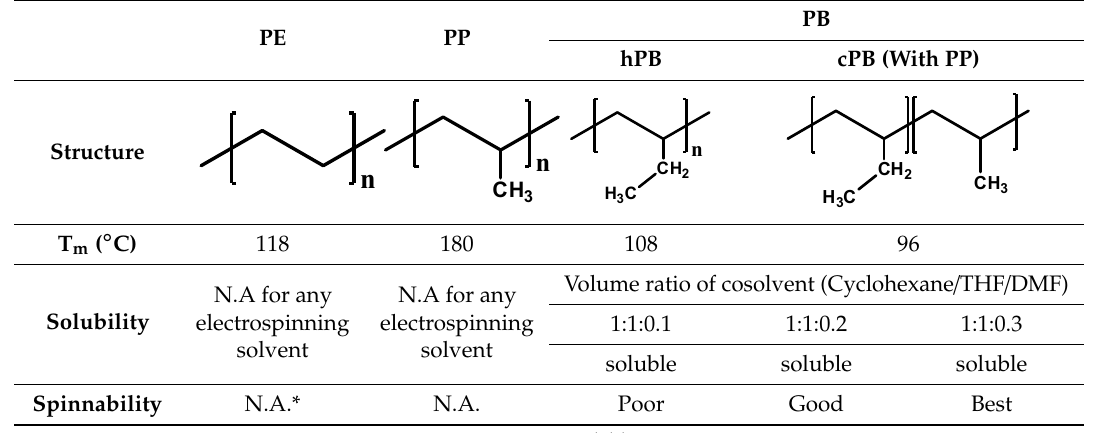
Table 1. Summary of several properties of PE, PP and PB.